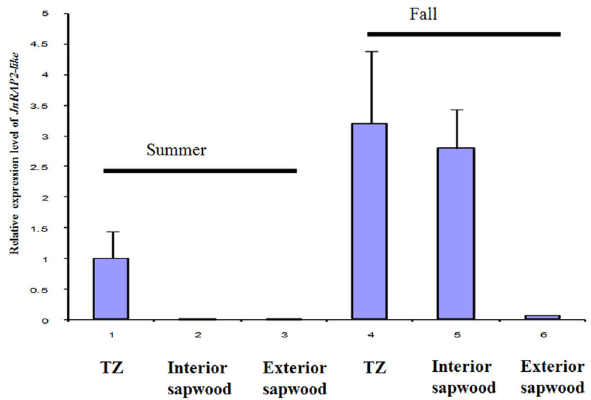
Figure 4. Transcript level of JnRAP2-like in the TZ, interior sapwood, and exterior sapwood from summer and fall trees. The fold changes were quantified by real-time PCR and were analyzed by the comparative C method by comparison T with the JnRAP2-like transcript level in the TZ of the summer tree. Values are the means ± SE for three biological replicates. 18S rRNA was used as a